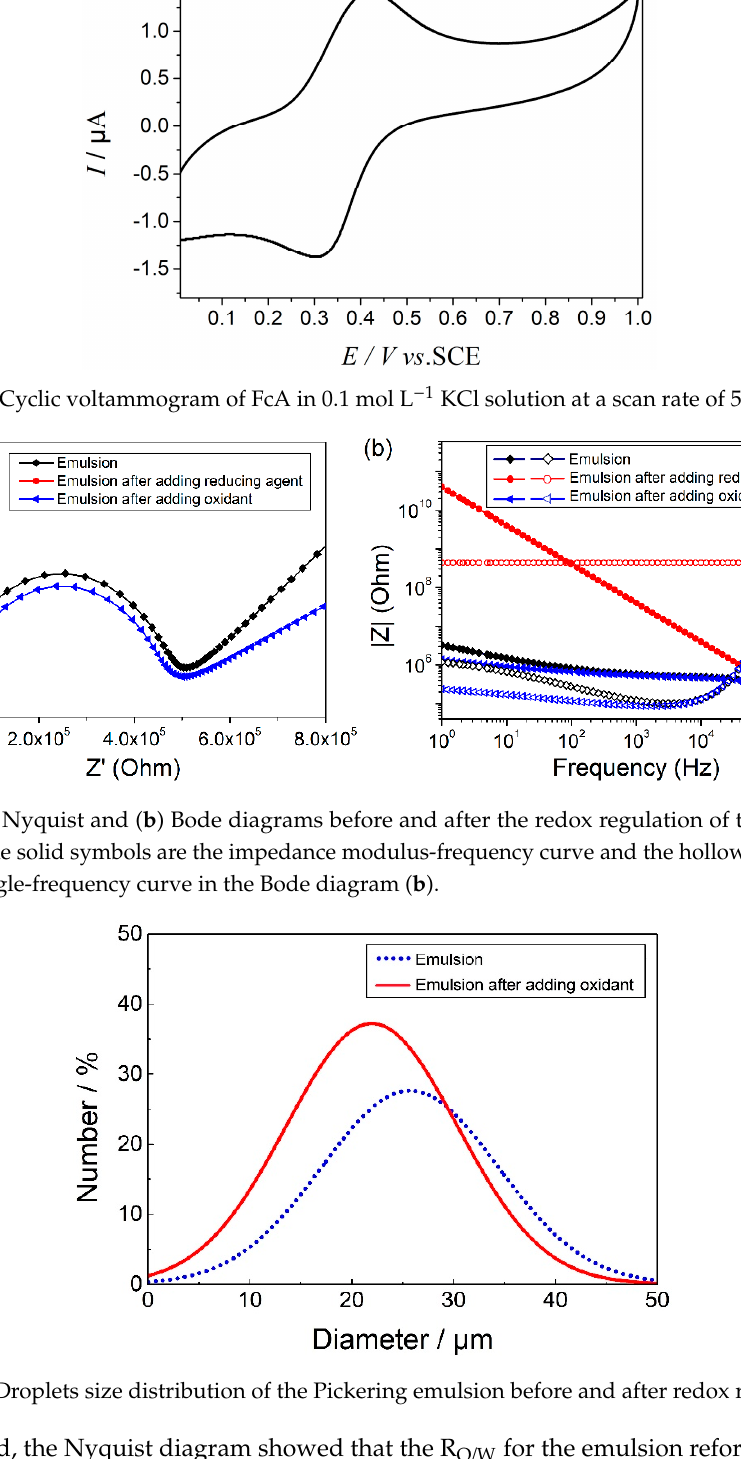
Figure 7. Cyclic voltammogram of FcA in 0.1 mol L − 1 KCl solution at a scan rate of 50 mV s − 1 .